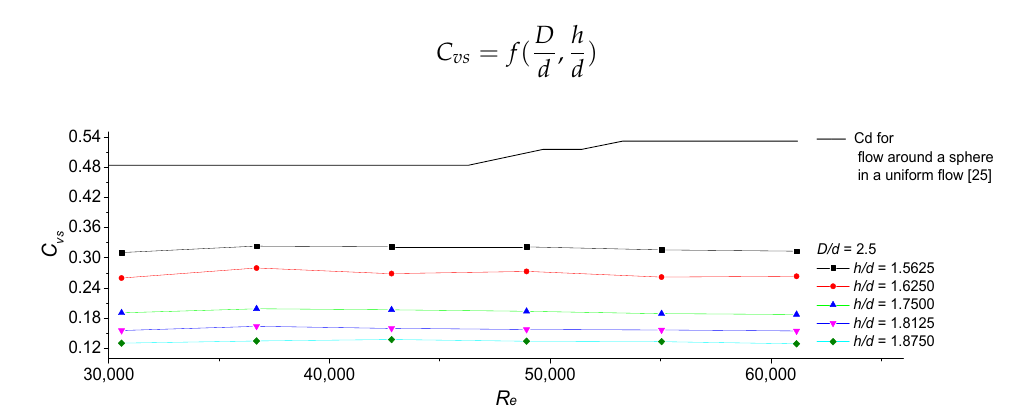
Figure 8. Relations between vertical suction force coefficients and Reynolds numbers.